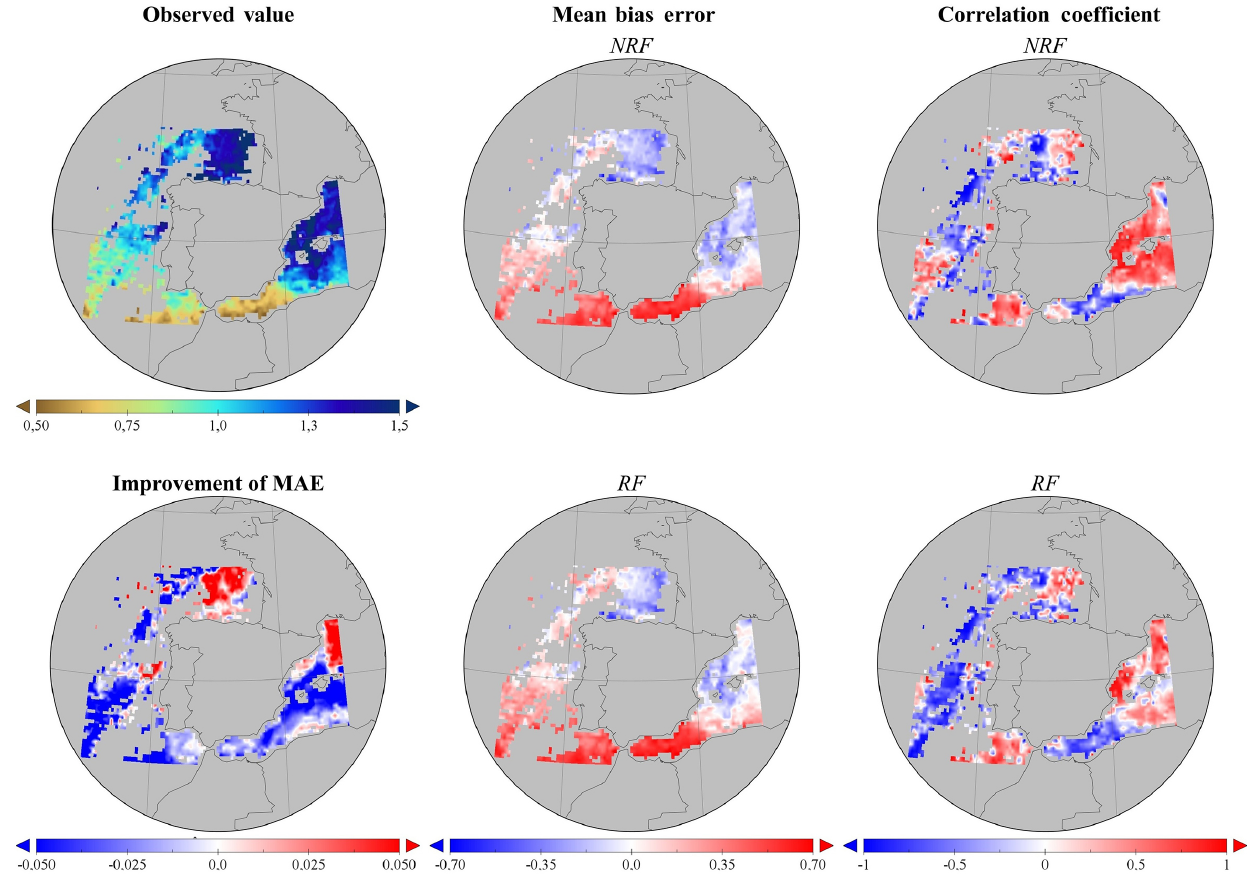
Figure 6. Comparison of AE 550 / 860 model output vs. AE at the same wavelength from MODIS data for the dust episode (temporal mean from 28 June to 12 July). AE MODIS values (top left), improvement of the MAE due to the inclusion of RF (MAE in RF-NRF simulations, bottom left), MBE for NRF (top centre) and RF simulations (bottom centre). Correlation coefficient for NRF (top right) and RF (bottom right)